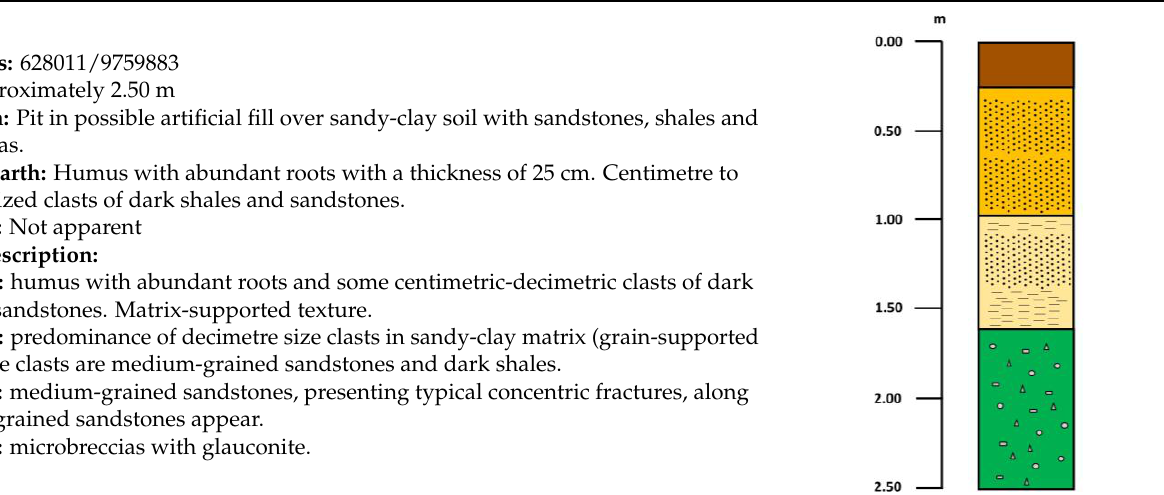
Table 9. Stratigraphic column of pit P08.